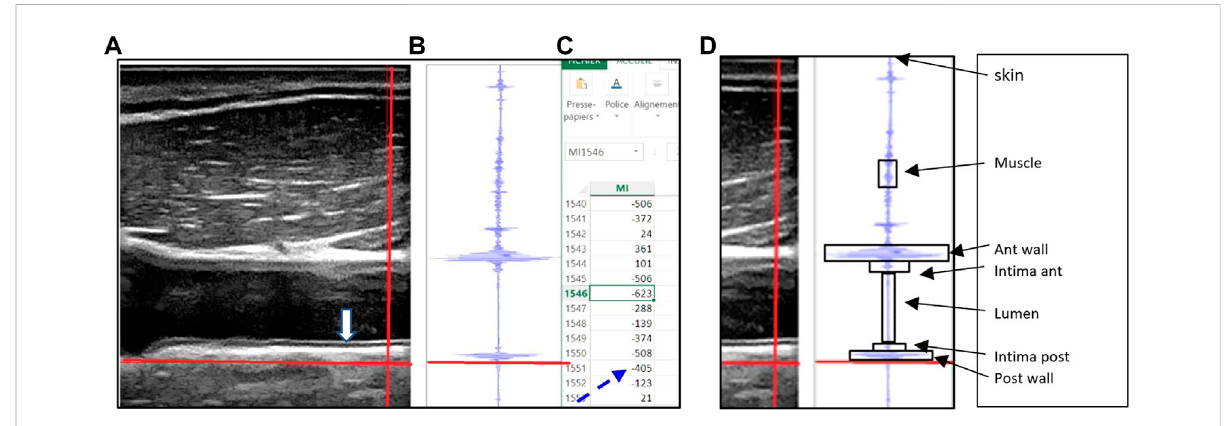
FIGURE 1 (A) Bmodeechoimagewiththemovable(red)crosshairsintersectingallofthefollowingstructures:thesternocleidomastoidmuscle,common carotid artery intima layers (anterior and posterior), lumen and artery wall (anterior and posterior), (B) the radiofrequency signal displayed graphically for points along the vertical (red) crosshair selected on the B mode image, along with the horizontal red line which allows the user to select